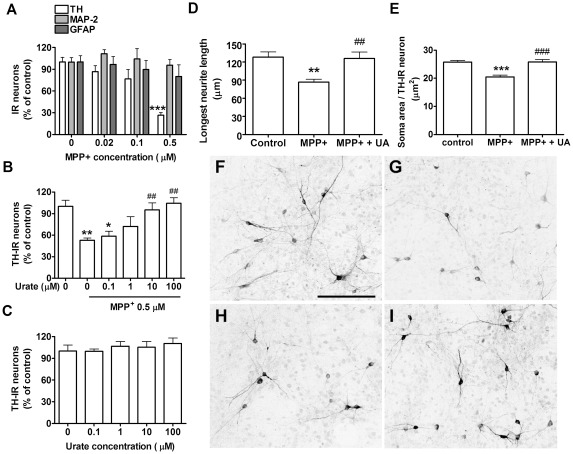
Urate's protective effect on dopaminergic neurons in mixed cultures.
A) MPP+ concentration-dependent effect on dopaminergic neuron, total neuron and astrocyte viability, expressed as percentage of TH-IR, MAP-2-IR and GFAP-IR cell number, respectively, in comparison to control cultures (n = 4). B) Urate concentration-dependent effect on TH-IR cell number in 0.5 µM MPP+-treated cultures (n = 5). C) Lack of effect of urate at any concentration on TH-IR cell number (n = 5). Urate (100 µM) effects on reductions in D) longest neurite length and E) soma size in MPP+ urate-treated TH-IR neurons. Photomicrographs show TH-IR neurons in F) control cultures, G) MPP+/0 urate-treated cultures and H) MPP+/0.1 urate-treated cultures and I) MPP+/100 µM urate-treated cultures. Scale bar = 50 µm. One-way ANOVA followed by Newman-Keuls test: *P<0.05, **p<0.01, ***P<0.001 vs 0 MPP+ value, ##
P<0.01 and ###
P<0.001 vs MPP+/0 urate value.